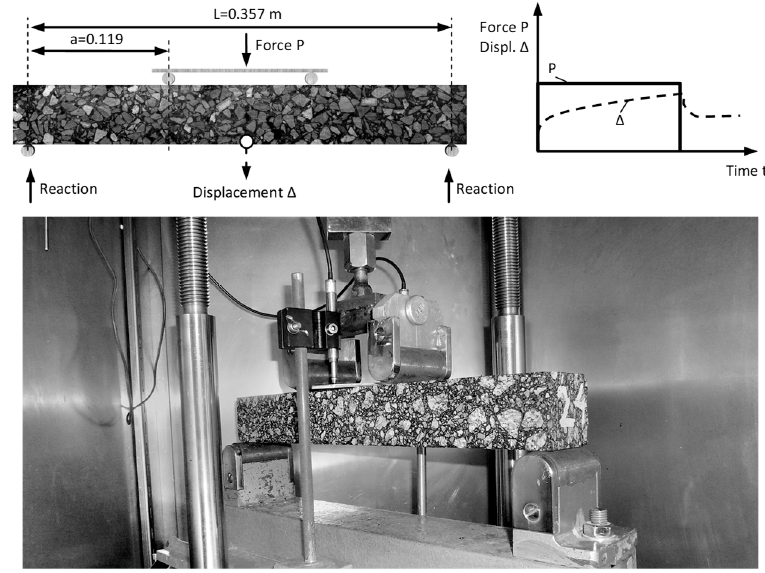
Figure 4. The scheme of the static four-point bending beam (4BP) creep test.